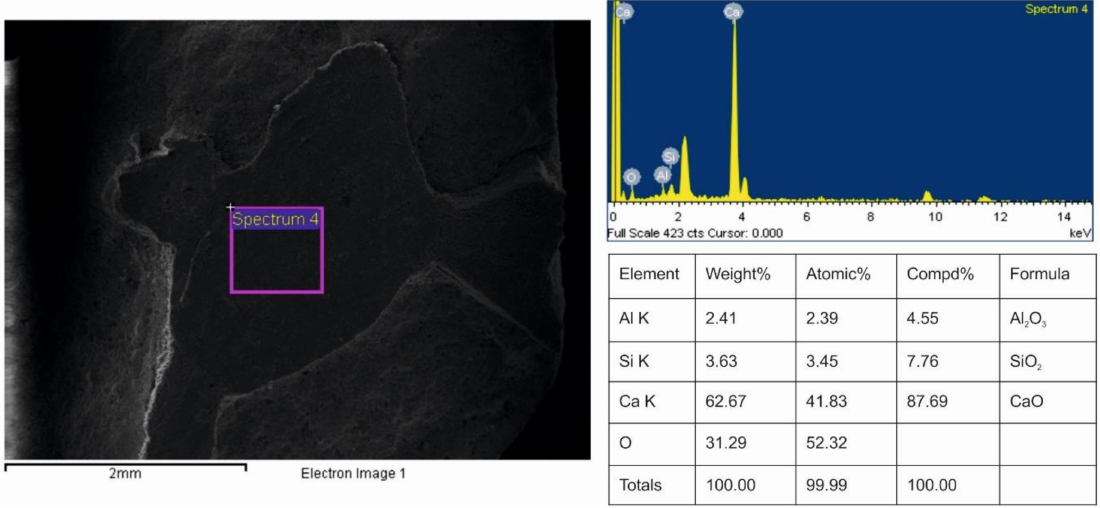
Figure 5. Scanning-electron-microscopy (SEM) image, and the energy-dispersive-spectrometer (EDS) spectrum and elemental quantification of MPC2.